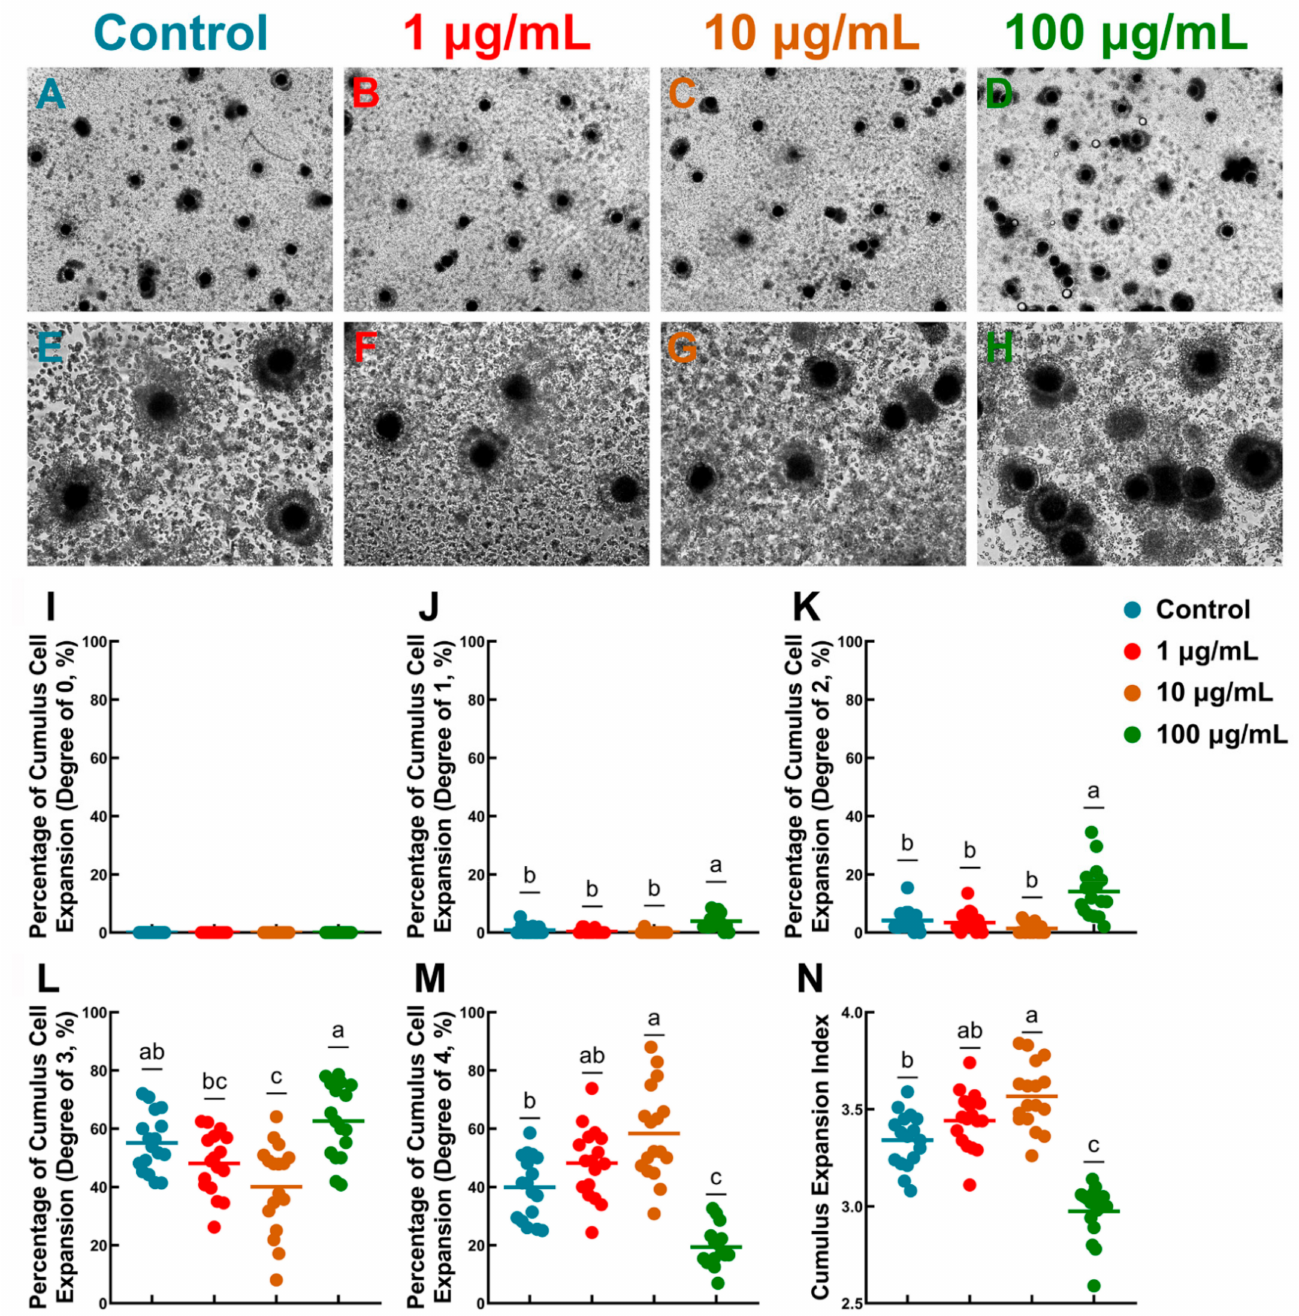
Figure 1. Evaluation of cumulus expansion in cumulus–oocyte complexes after 42 h of in vitro maturation: ( A , E ) Control group, ( B , F ) 1 µ g/mL TA, ( C , G ) 10 µ g/mL TA. ( D , H ) 100 µ g/mL TA. ( A – D ) Original magnification × 40. ( E – H ) Original magnification × 100. ( I – M ) Different degrees of cumulus expansion (%); ( N ) total cumulus expansion index. Bars with different letters denote significant differences ( p < 0.05). Results are shown as the average ± SEM of seventeen repeats of independent